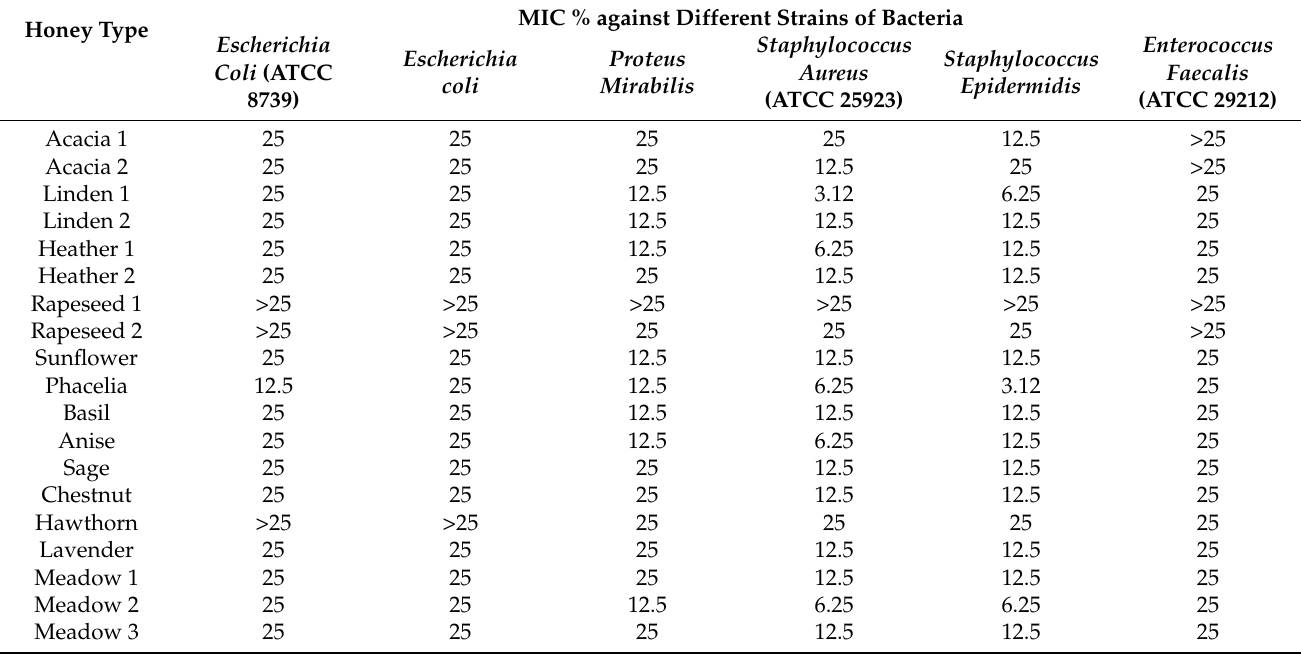
Table 4. Minimum inhibitory concentrations (MIC, %) of different types of honey against tested strains of Escherichia coli (ATCC 8739), Escherichia coli , Proteus mirabilis , Staphylococcus aureus (ATCC 25923), Staphylococcus epidermidis , and Enterococcus faecalis (ATCC